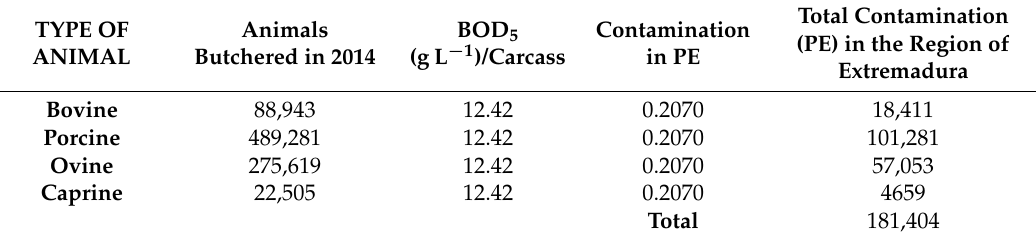
Table 6. Pollution expressed in population equivalents (PE) in